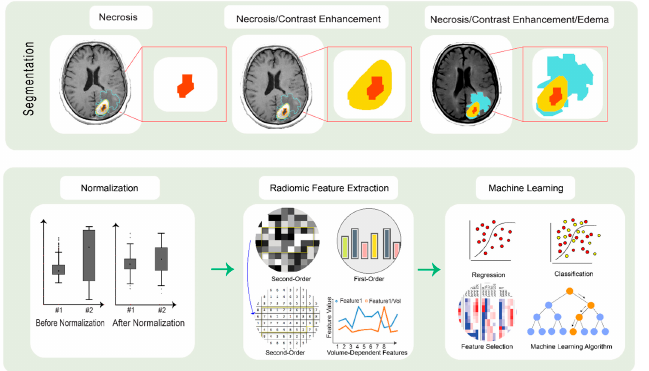
Figure 1. Radiomics pipeline for brain tumors. Top line: segmentation of the three imaging phenotypes: necrosis ( left ), enhancement/edema ( middle ) and enhancement/edema/invasion ( right ). Bottom line: radiomics feature extraction from MR images, data value normalization and volume-dependent feature generation are followed by predictive modeling for outcomes.